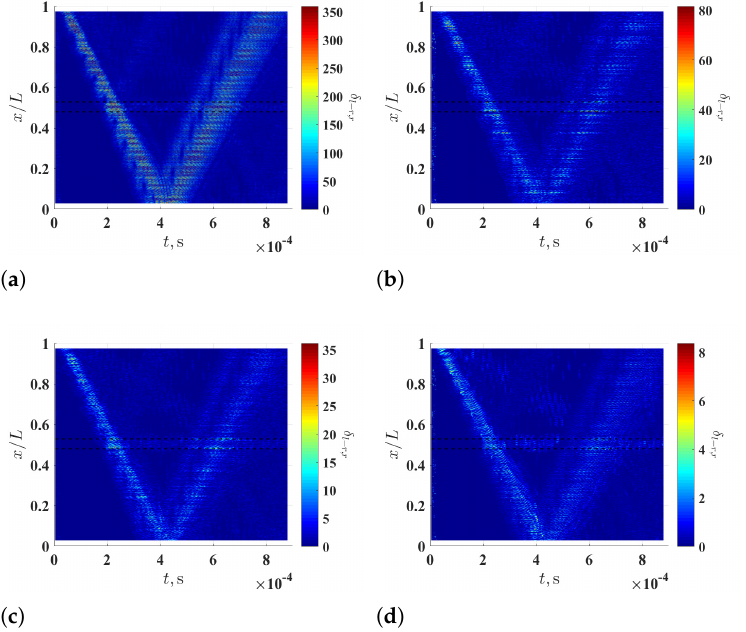
Figure 9. Multi-resolution local-regression TSCDI δ l − r , r associated with the measured wave of the damaged beam with ( a ) r = 1, ( b ) r = 8, ( c ) r = 16 and ( d ) r = 32 and ξ = 5%. Locality and extent of the damage are indicated by two dashed